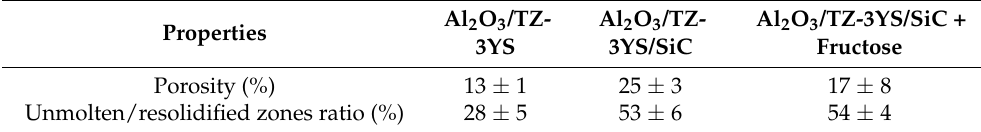
Table 2. Porosity and unmolten/resolidified zones ratio in the coatings.